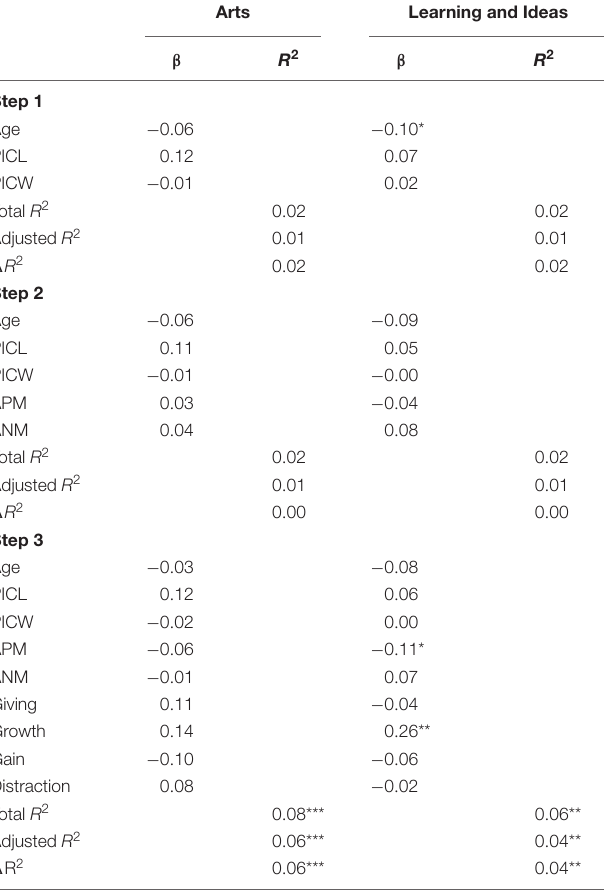
TABLE 7 | Results of hierarchical regression analysis predicting change in TABLE 6 | Results of hierarchical regression analysis predicting change in creativity in Arts and Learning and Ideas during COVID-19 lockdown in Germany. creativity in Arts and Learning and Ideas during COVID-19 lockdown in China. Arts Learning and Ideas Arts Learning and